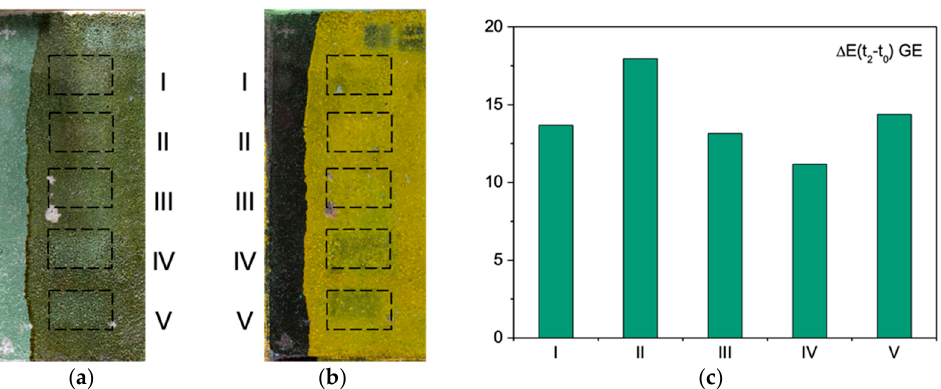
Figure 6. Green Earth specimen as a function of laser treatment (I–V): ( a ) visible image; ( b ) UV-induced visible fluorescence; ( c ) bar plot of ∆ E values. Each tested area I–V refers to 1 × 2 cm 2 area. Table 5. Colorimetric L*, a*, b* parameters and their standard deviations (std) of the Green